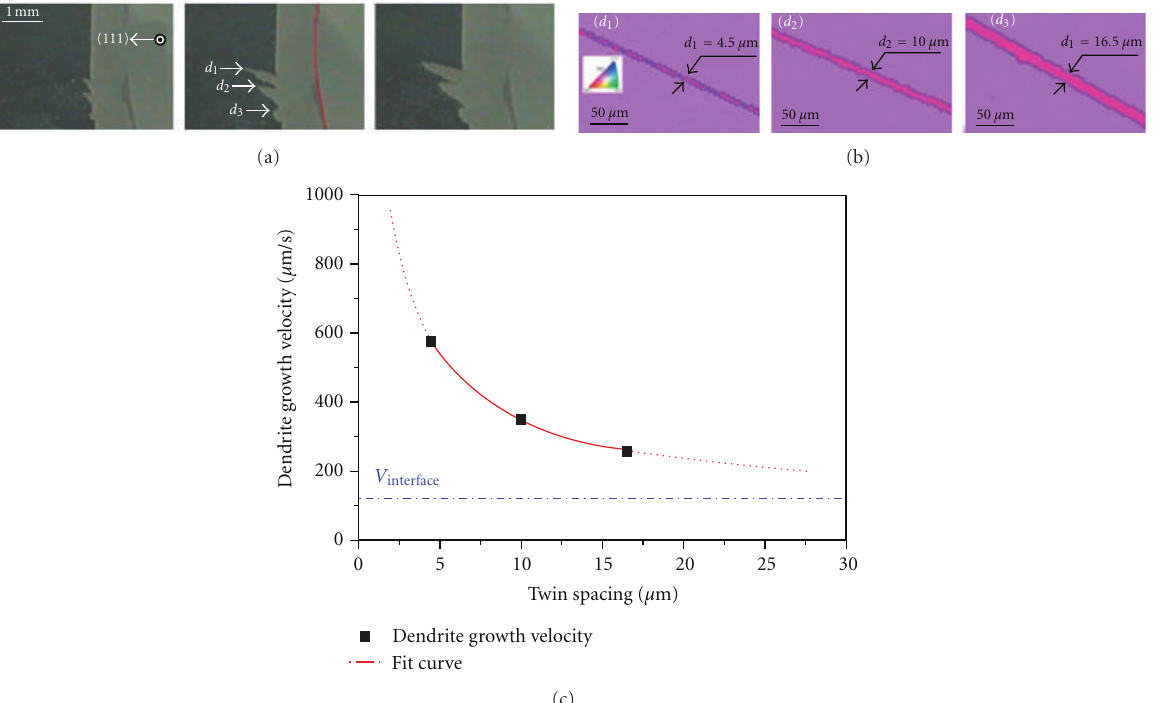
Figure 19: (a) Growth process of three dendrites (d1, d2, and d3) grown from same crystal-melt interface at same time [75]. (b) Parallel twins observed at center of d1, d2, and d3 by EBSP measurement. The average twin spacings in d1, d2, and d3 are 4.5 μ m, 10 μ m, and 16.5 μ m, respectively [75]. (c) Dendrite growth velocity as function of twin spacing